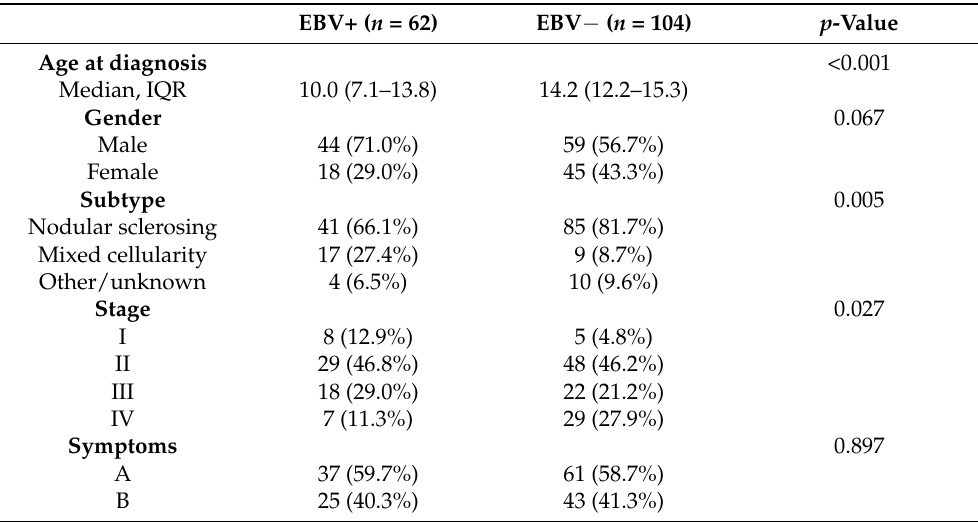
Table 3. Clinicopathological variables according to EBV status. Stage, subtype and symptoms were defined following review. Interquartile range